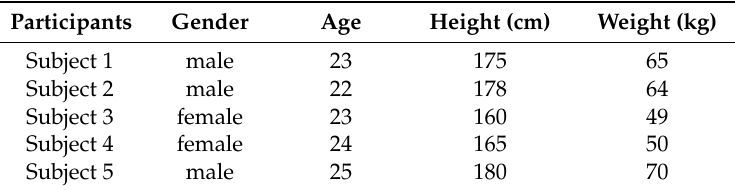
Table 3. Information of all involved